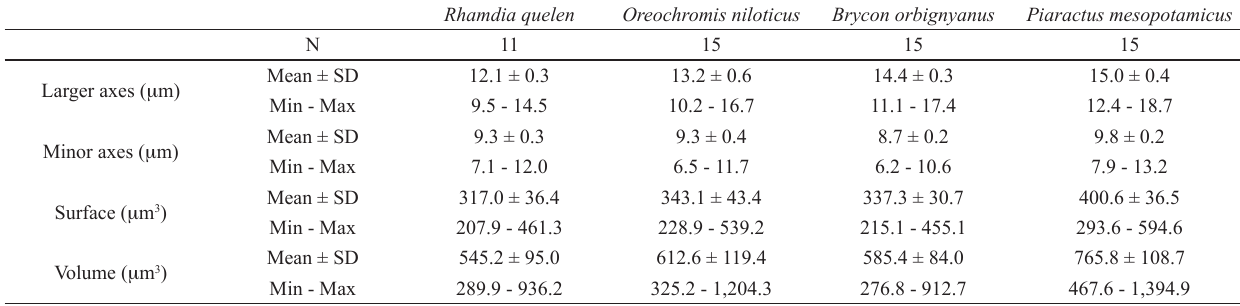
Table 3. Sample number (N), mean ± standard deviation (SD), coefficient of variation (CV), and minimum and maximum of larger axes ( m m), minor axes ( m m), surface ( m m 3 ) and volume ( m m 3 ) of red blood cells of Rhamdia quelen , Oreochromis niloticus , Brycon orbignyanus and Piaractus mesopotamicus maintained under controlled conditions for a period of 30 days. Values are means of 50 random cells measured in 11 - 15 blood